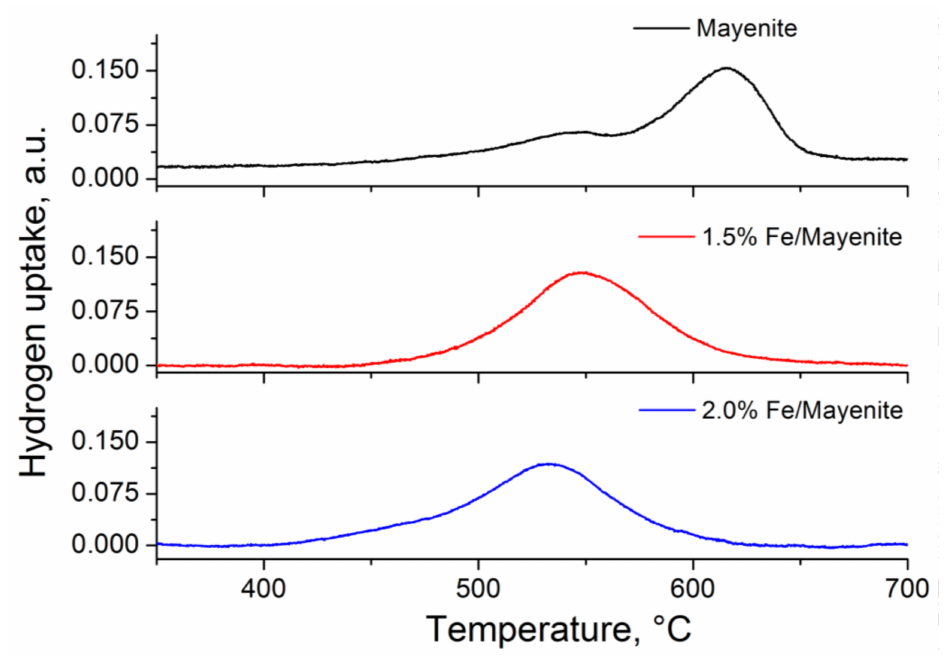
Figure 3. H 2 -TPR profiles of mayenite (black), 1.5% Fe / mayenite (red), and 2.0% Fe / mayenite (blue).